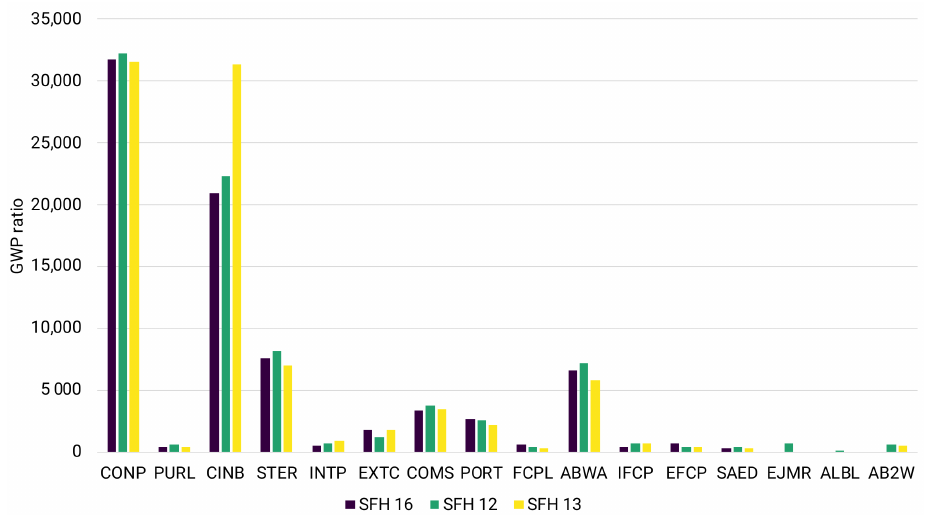
Figure 6. Main building materials constituting three typical houses: CONP—Concrete paving, PURL—Purlins, CINB—Cinder block, STER—Steel roofing, INTP—Interior plastering, EXTC— External coating, COMS—Concrete mortar screed, PORT—Porcelain tile, FCPL—False celing in plas- terboard, ABWA—American block wall, IFCP—Interior facade coating type paint, EFCP—External facade coating type paint, SAED—Solid aluminium entrance door, EJMR—Exterior joinery type motorized roller shutter, ALBL—Aluminium blinds, AB2W—Aluminium bay window.